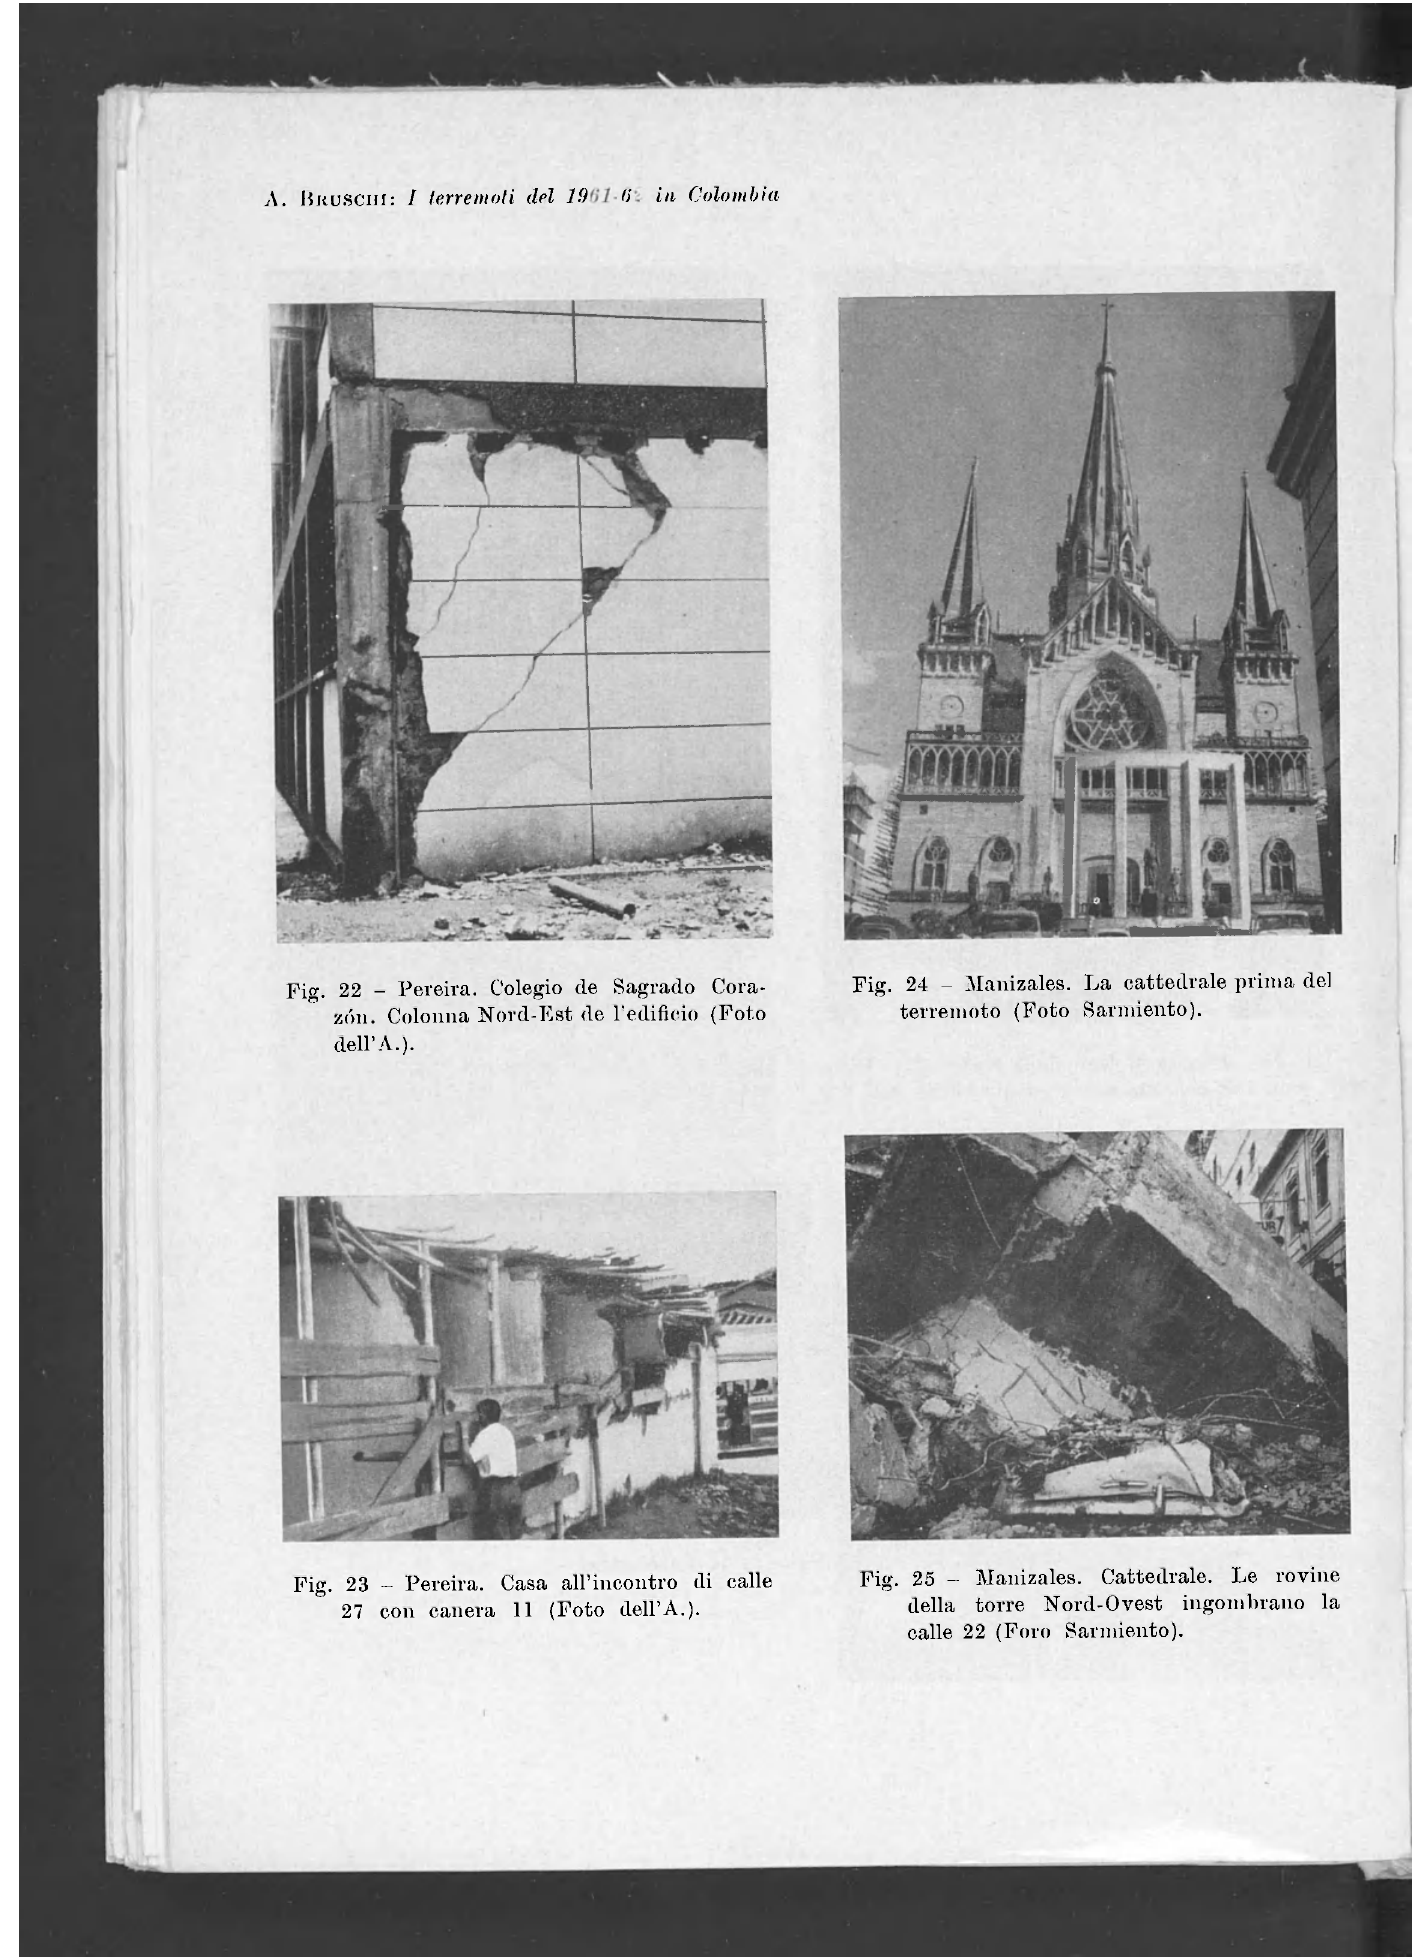
Fig. 23 - Pereira. Casa all'incontro di calle 27 con canera 11 (Foto dell'A.).